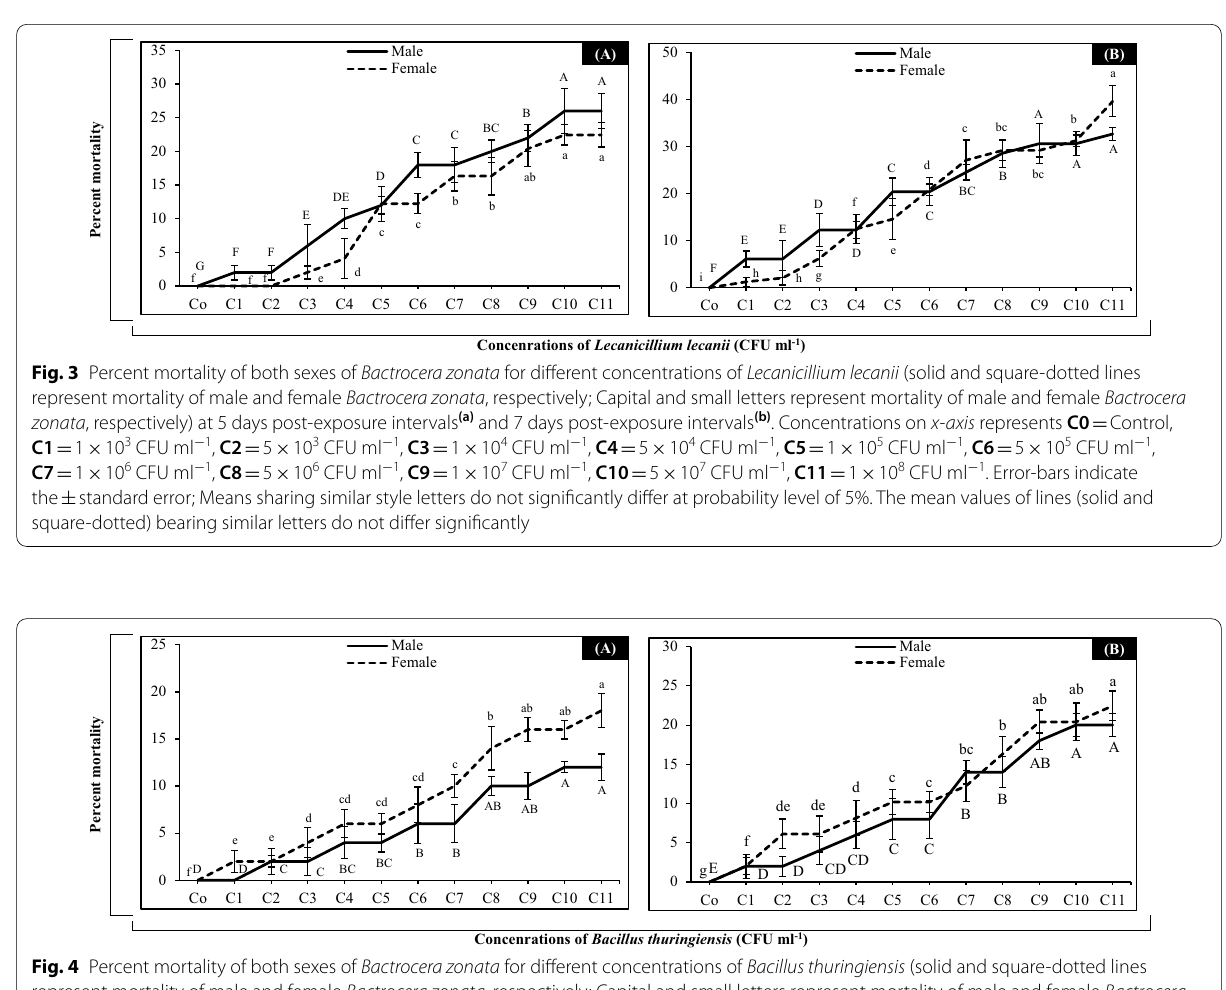
Control, = 5 10 5 CFU ml − 1 , = ×